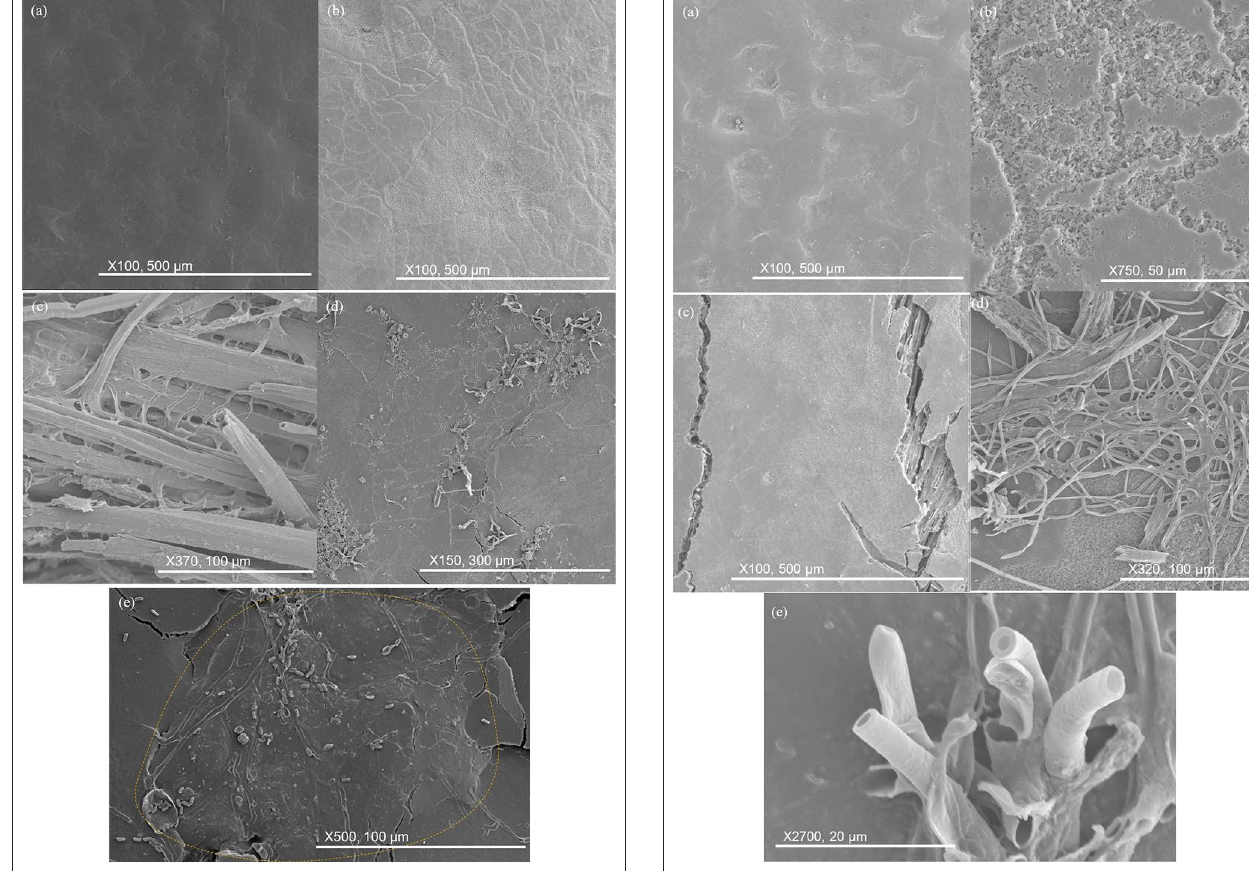
to form a system of hyphae known as mycelium. The peanut shaped features are likely to be spores that initiate the hyphae structure. This is consistent with the reduction in the number